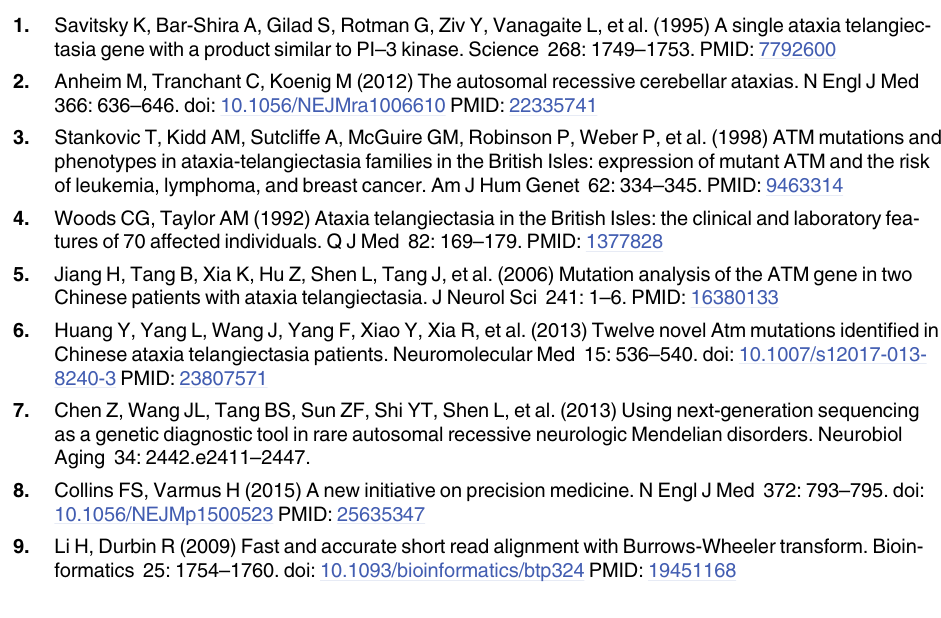
S1 Fig. Details of coverage read of putative pathogenic mutations. IGV-browser revealed sufficient coverage read of each causative variant aligned to ATM gene found by targeted